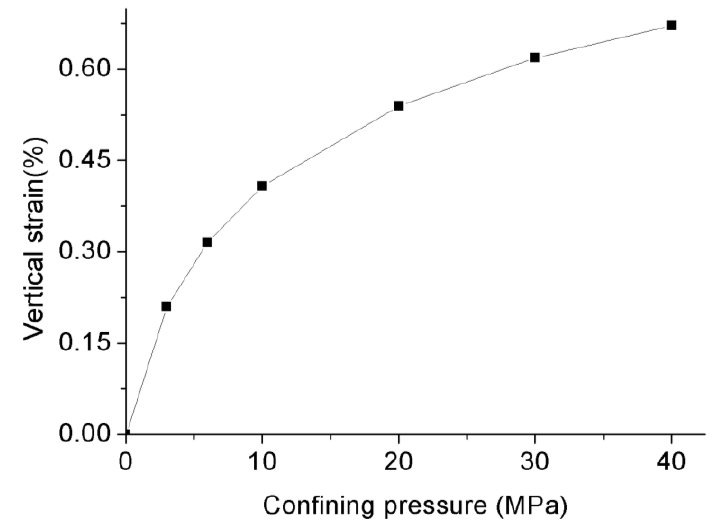
Figure 14. Vertical displacement at different confining pressures.